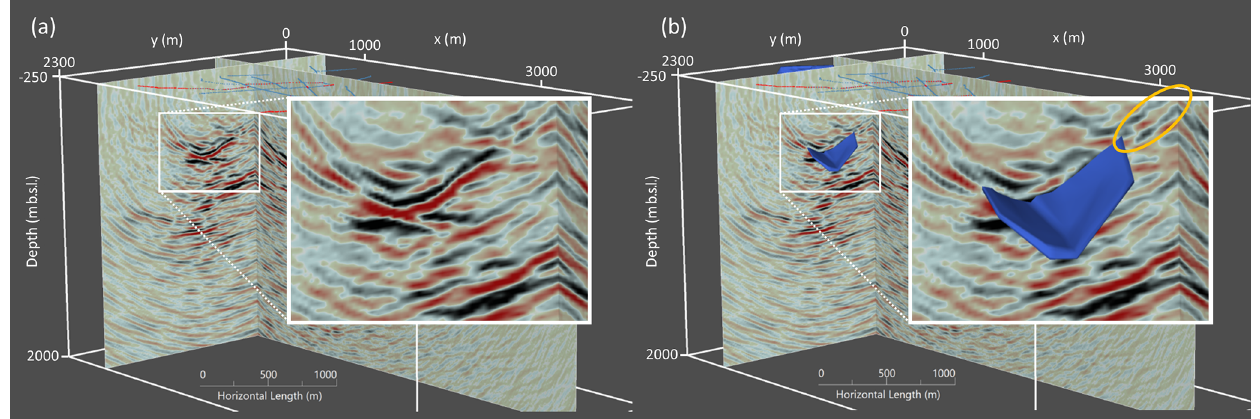
Figure 9. Perspective view (a) without and (b) with the model of the known mineralization (blue body). The zoomed inset shows the good agreement of the position, depth, and shape of the known mineralization and the corresponding reflectors in the seismic image.